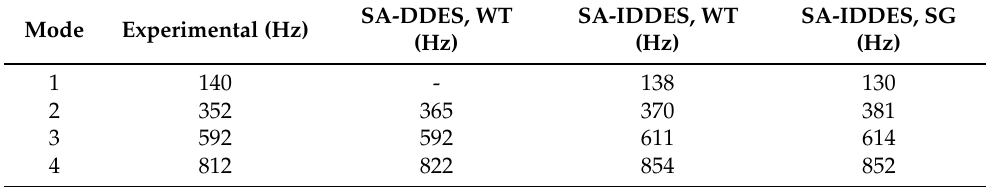
Table 3. Rossiter mode frequencies. WT and SG denote the wind tunnel model and simplified geometry,